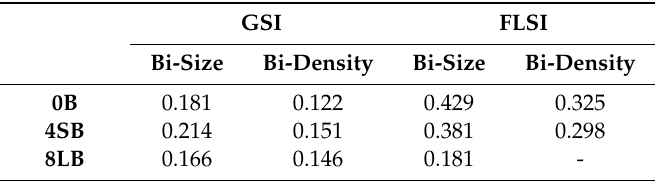
Figure 9. The simulated segregation indexes: global (GSI), front layer (FLSI) and rear layer (RLSI) versus mixing time for the bi-size bed (drum filled at ¼, 8 baffles of 4 cm). Table 5. Global and front layer segregation indexes after 2 min (6 revolutions) of mixing (drum filled at 1 / 8, 0B: no ba ffl es, 4SB: 4 ba ffl es of 1.5 cm, 8LB: 8 ba ffl es of 4